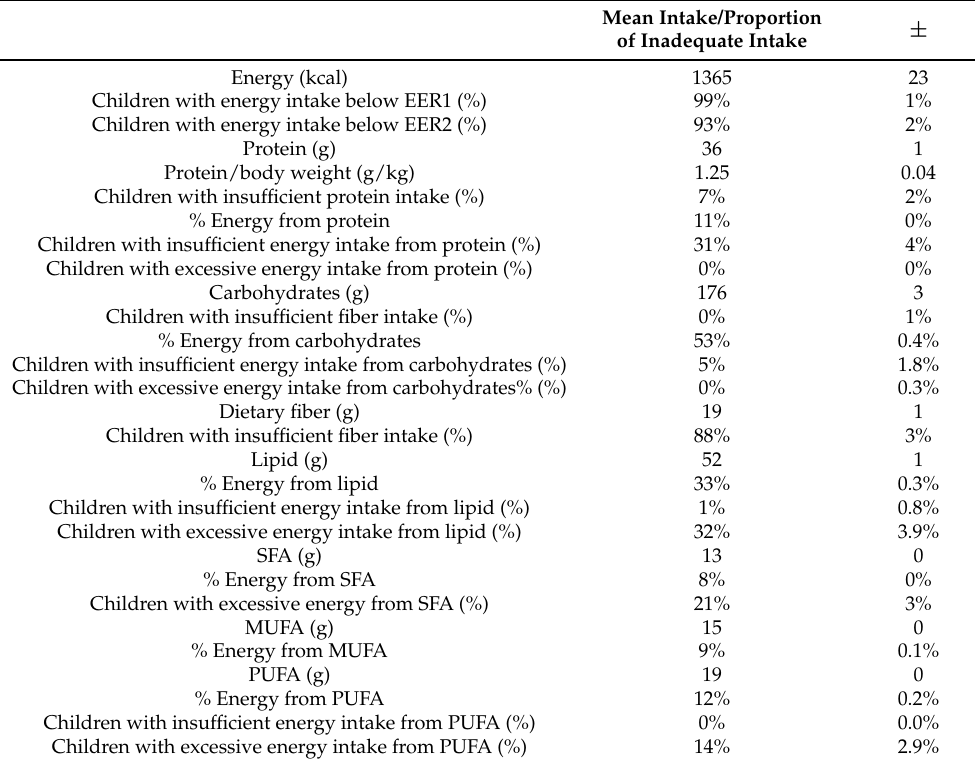
Table 1. Mean energy and macronutrient daily intake (adjusted for within-person variability) and prevalence of insufficient and excessive macronutrient daily intake.